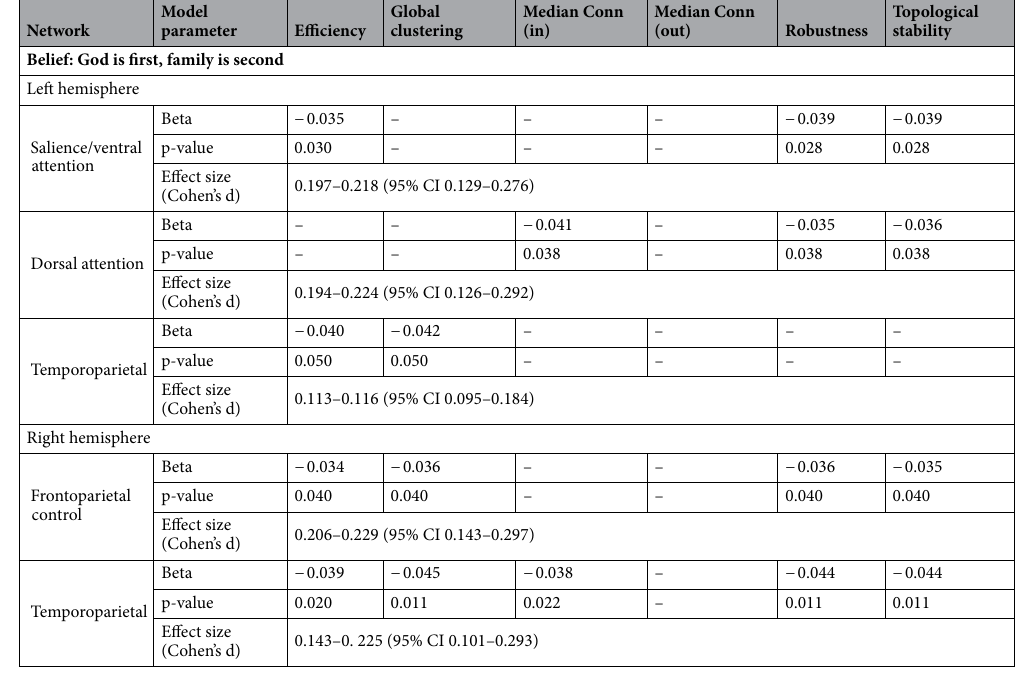
Table 5. Parameters of models assessing the relationship between the belief that ‘ God is first, family is second’ and individual network properties. Reported p-values have been adjusted for FDR and beta coefficients have been standardized. Median connectivity within the network (in) and between a network’s nodes and the rest of the brain (out) are also reported. Across properties, effect sizes (Cohen’s d) were calculated with strength of belief = 1 (not at all) as the reference, with adjustments for unequal sample sizes. A range of effect sizes across properties, and 95% confidence intervals (CI) are